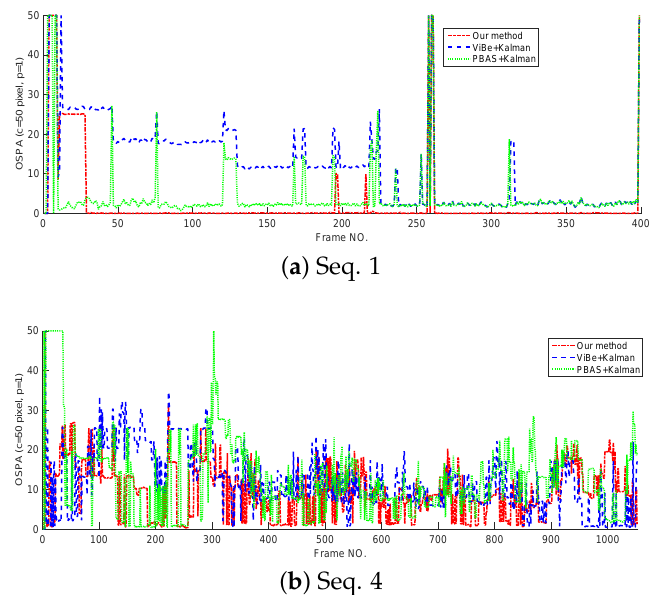
Figure 9. The OSPA of different